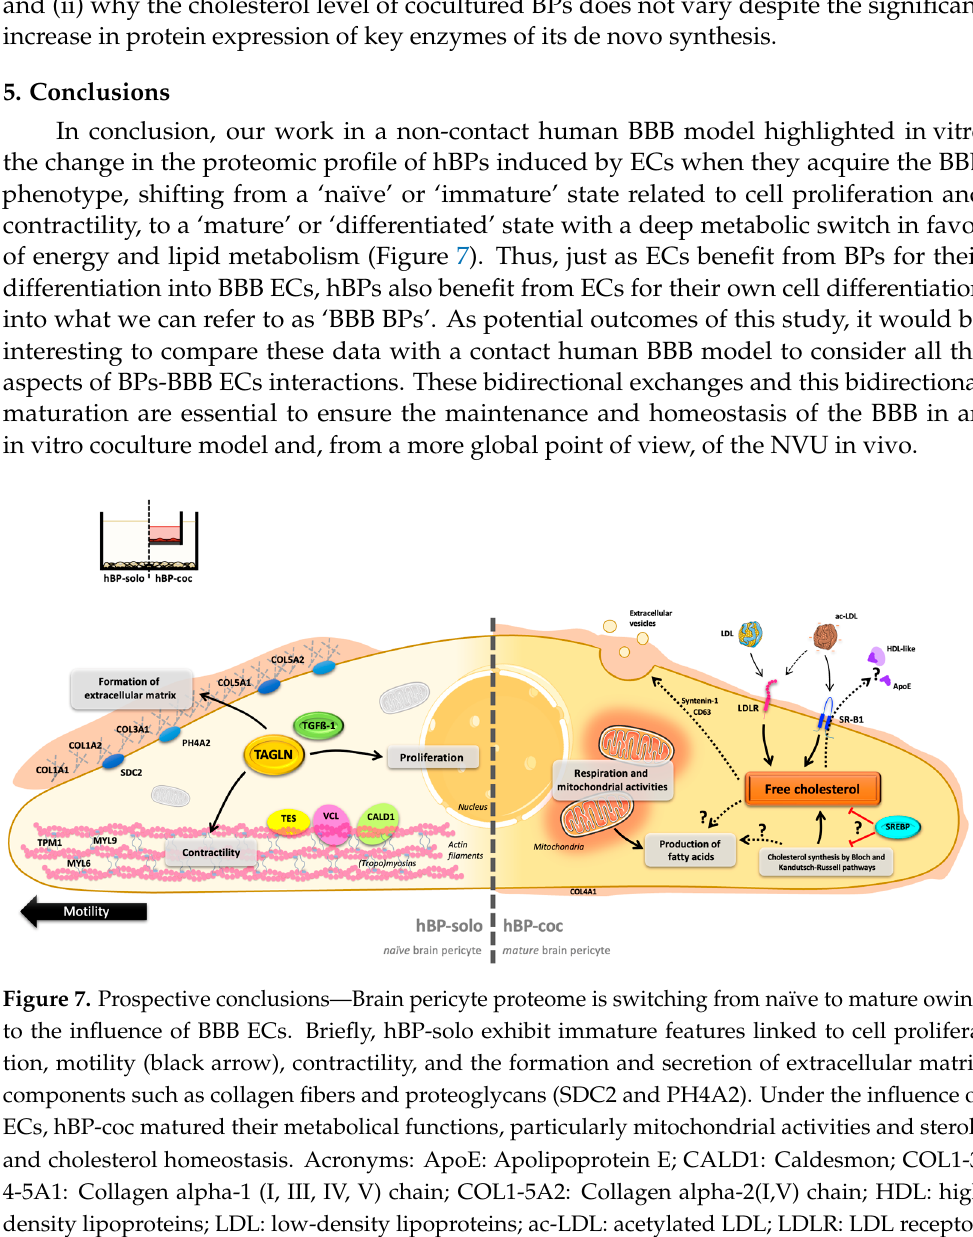
Tropomyosin alpha-1 chain; VCL: